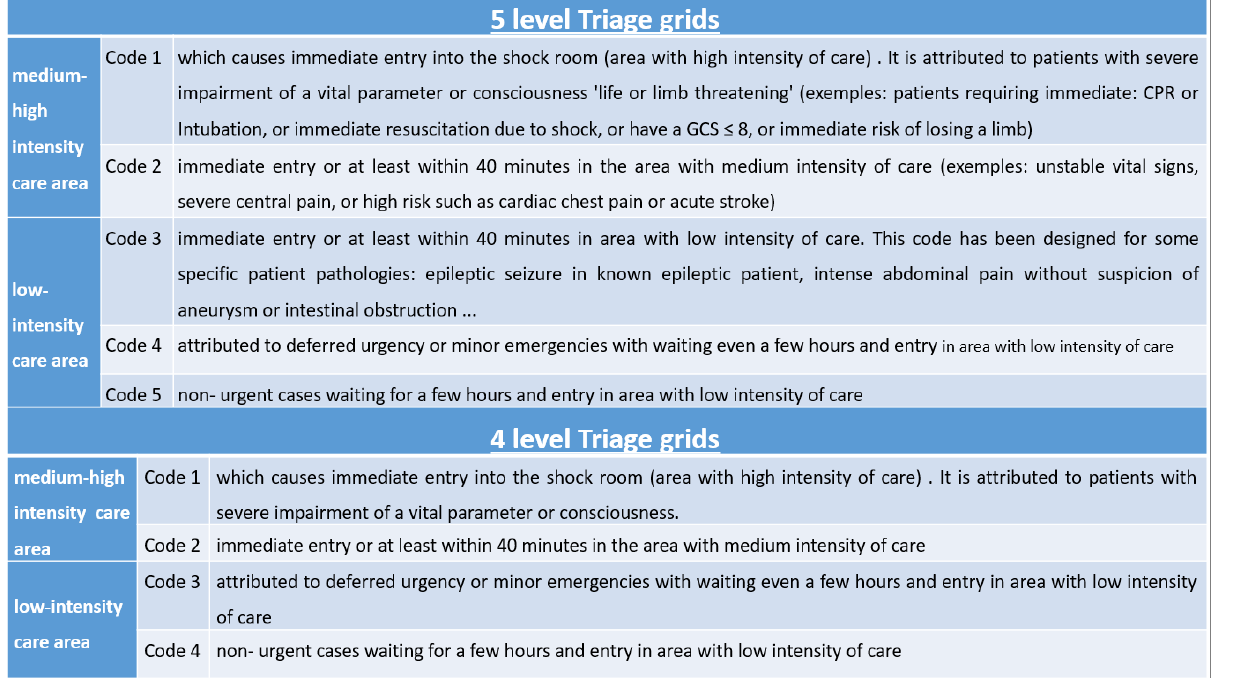
Figure 2. 4LT and 5LT grids.